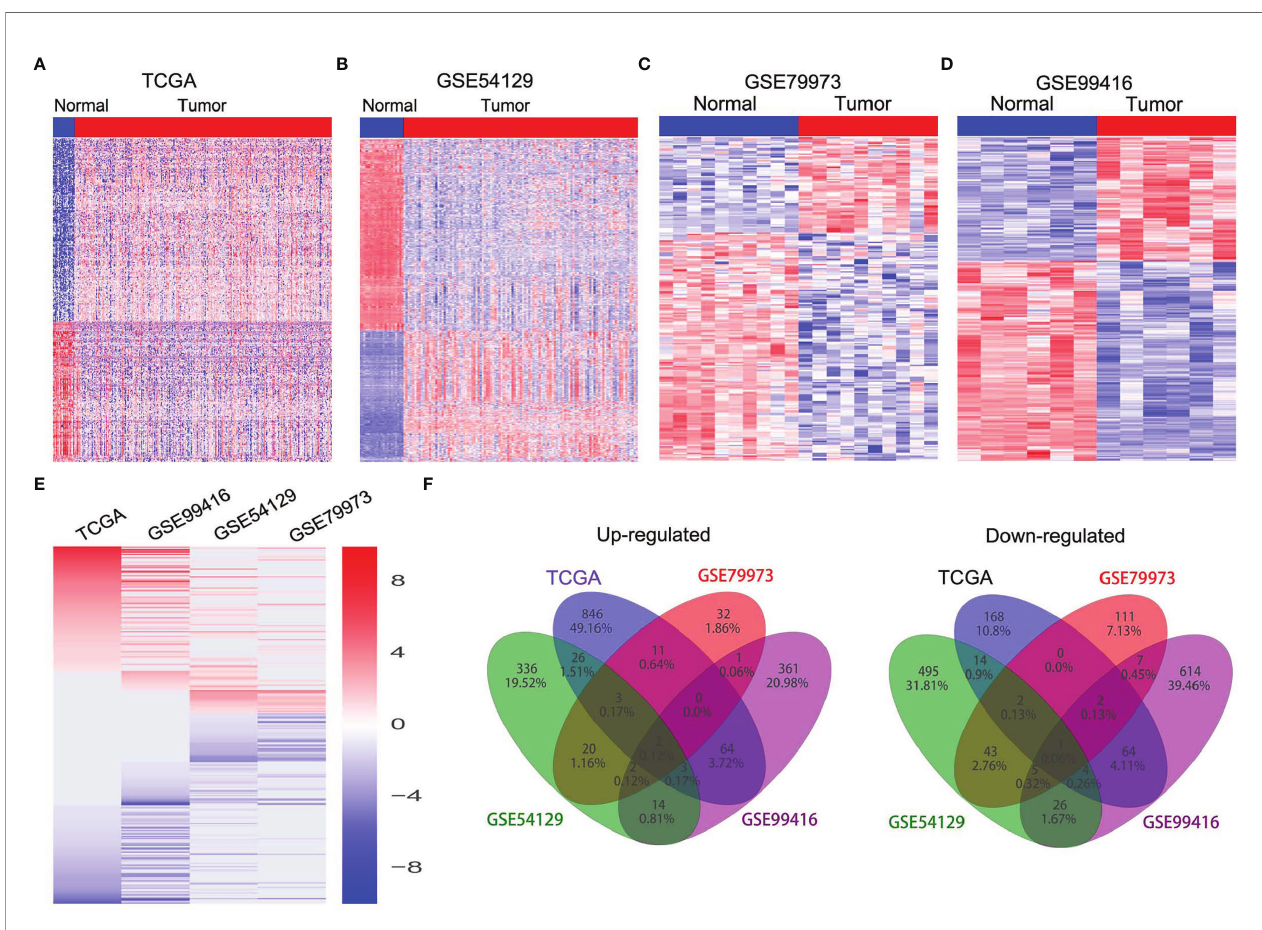
FIGURE 1 | The expression pro fi les of lncRNAs in GC tissues. (A) Heatmap of the differentially expressed lncRNA expression in GC and normal tissue samples was analyzed using the TCGA datasets. (B) Heatmap of the differentially expressed lncRNA expression in GC and normal tissue samples was analyzed using the GSE54129 datasets. (C) Heatmap of the differentially expressed lncRNA expression in GC and normal tissue samples was analyzed using the GSE79973 datasets. (D) Heatmap of the differentially expressed lncRNA expression in GC and normal tissue samples was analyzed using the GSE99416 datasets. (E) Heatmap of the altered lncRNAs pro fi ling in TCGA, GSE54129, GSE79973, GSE99416 datasets. (F) Venn diagram of altered lncRNAs in TCGA, GSE54129, GSE79973, and GSE99416